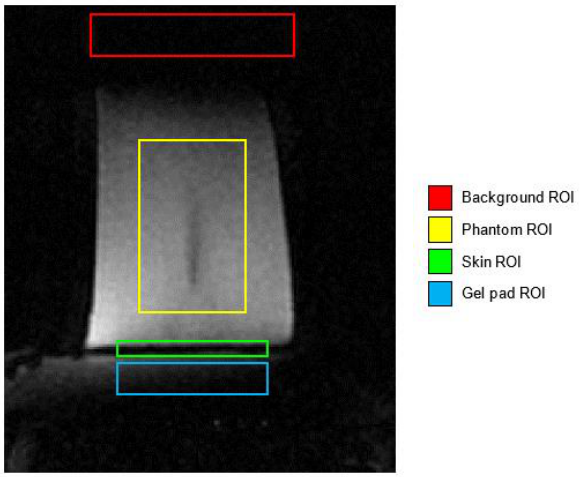
Figure 5. The ROIs investigated for the SNR estimation. The different ROIs that were drawn were the tissue-mimicking phantom (yellow), skin interface (green), gel pad (cyan), and background area (red).